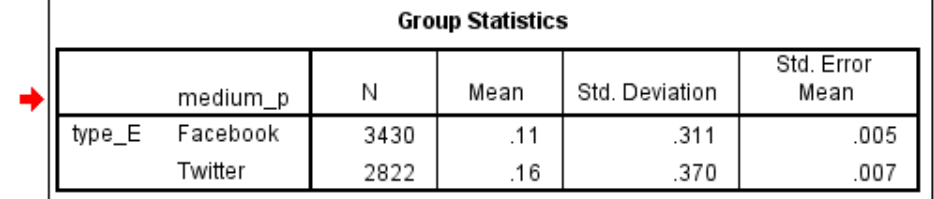
Figure 2. Statistic Facebook/Twitter Posts Mean/Std.